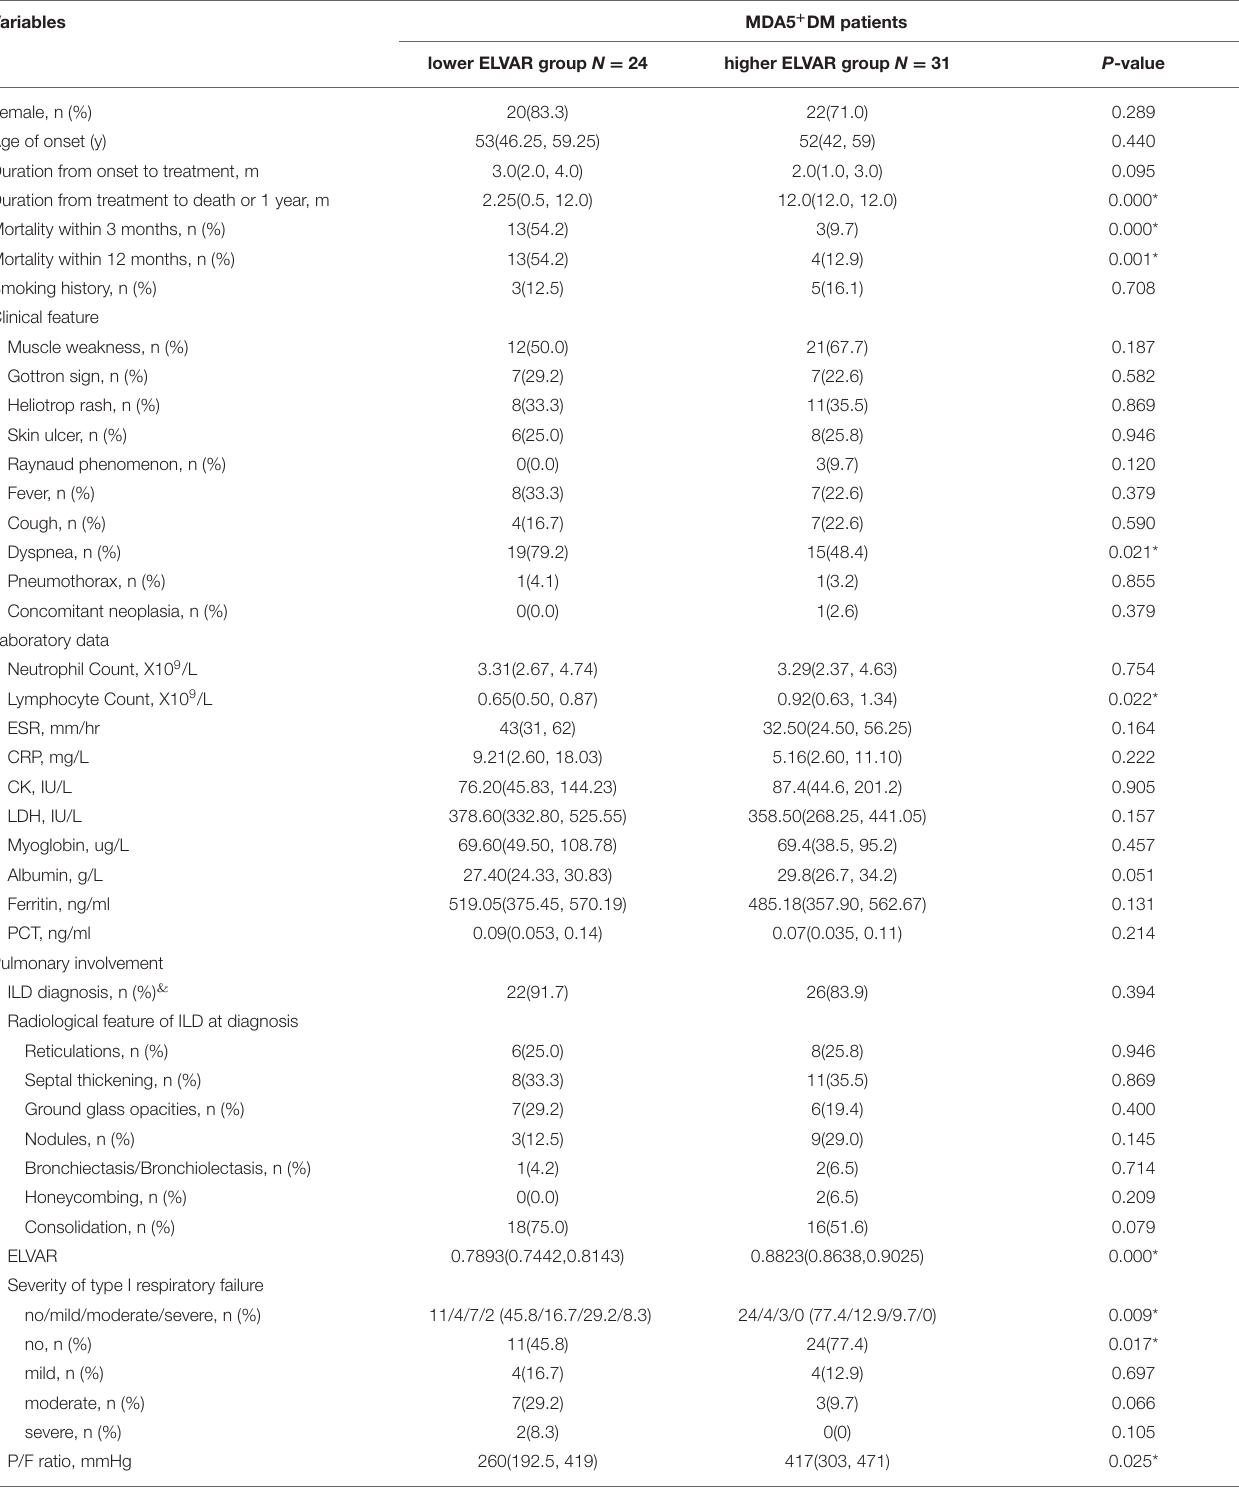
TABLE 4 | Comparison between lower ELVAR group and higher ELVAR group.